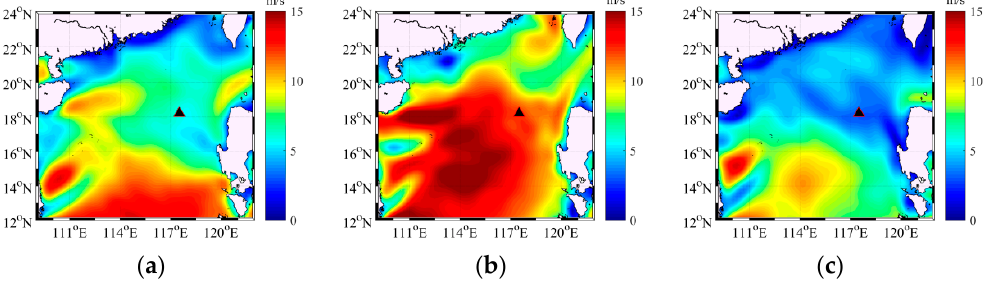
Figure 11. Wind speed field in experiment (unit: m/s) at ( a ) 3:00, 13 August ( b ) 22:00, 16 August ( c ) 3:00, 20 August.